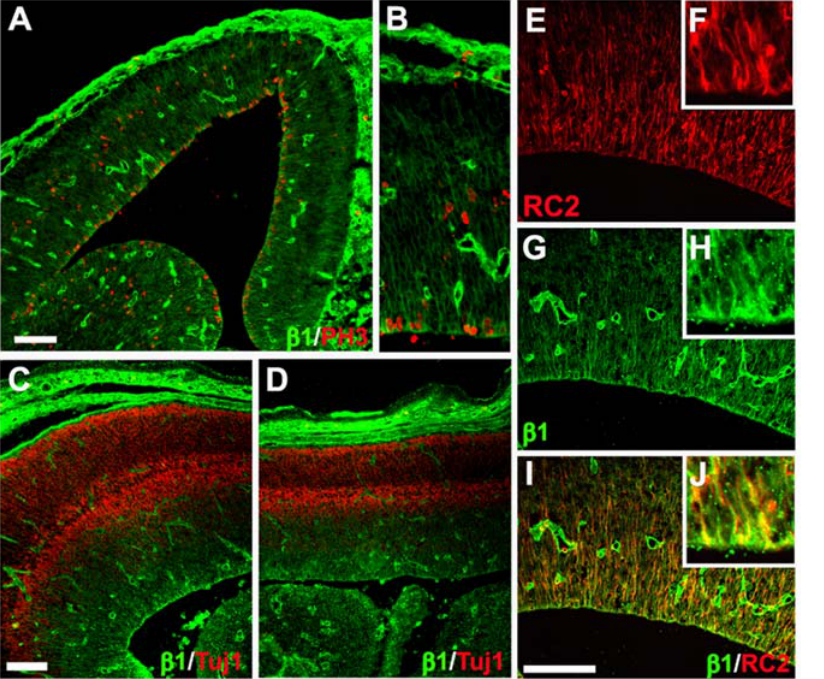
Figure 1. b 1 integrin is expressed by radial glia and proliferating cells at the ventricular surface during neurogenesis. (A–J) Fluorescent micrographs of E13 coronal (A, B, E–J) or E16 sagittal (C, D) sections immunostained as indicated. Both at the rostral (A–C, E–J) and medial (D) levels, b 1 integrin is expressed in PH3 + proliferating cells (A, high magnification B) and radial glia RC2 + cells (E–J) at the apical surface but not in Tuj1 + neurons (C, D). All scale bars represent 100 m m.